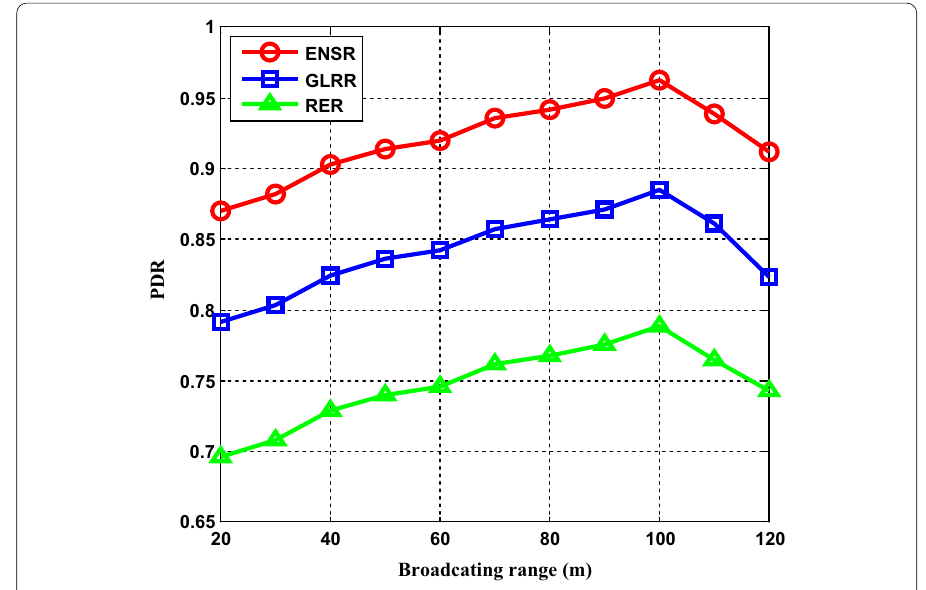
Fig. 6 PDR under different broadcasting range bR